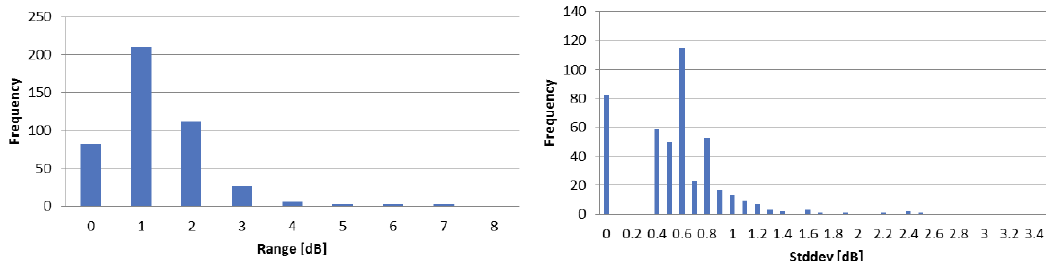
Figure 6. Distribution of the maximum amplitude range and standard deviation over pull series.